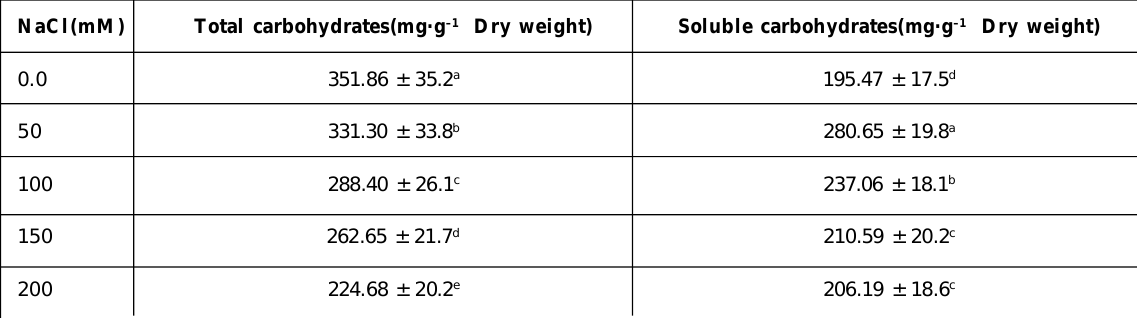
Table 5: Impact of different concentrations of NaCl on total and soluble carbohydrate contents in Phaseolus vulgaris